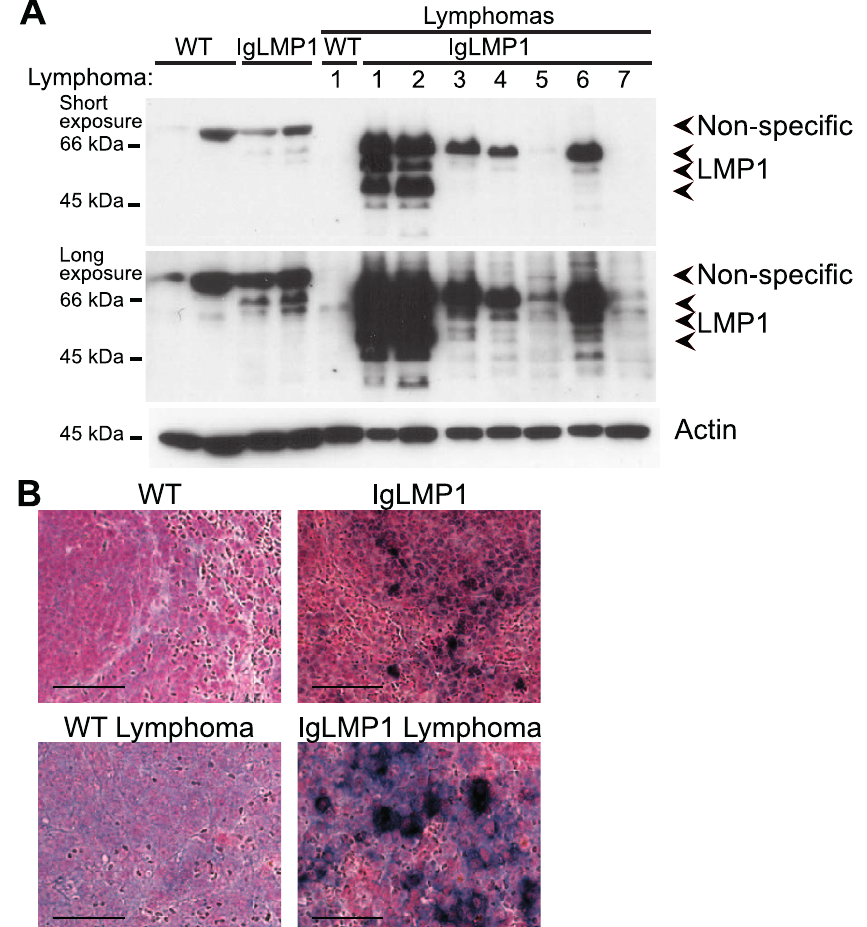
Figure 1. High LMP1 Expression Correlates with the Development of Lymphoma LMP1 expression is shown by (A) immunoblotting of purified B cells (CD19 þ ) and (B) immunohistochemistry staining of spleen tissue from wild-type (WT) and LMP1 transgenic mice. (A) Lymphomas are identified with a number (1–7). Arrows indicate the LMP1-specific band and its degradation products as well as a non-specific band. Actin was used as a loading control. (B) White and red pulps are shown, but this architecture is lost upon development of lymphoma. Scale bar, 20 l m.